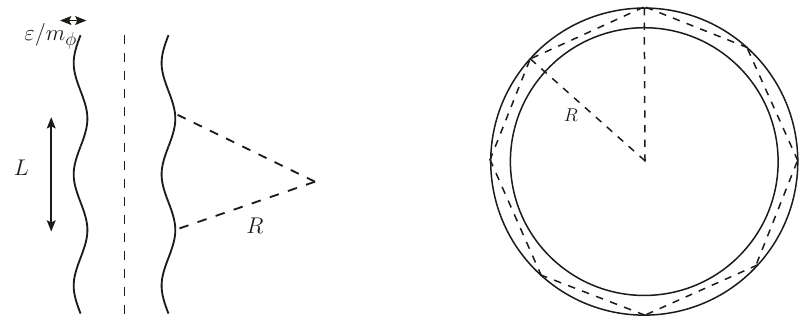
Figure 2 . The schematic pictures of curved string and its loop-like object. The typical curvature radius and the period of curves are denoted by R and L